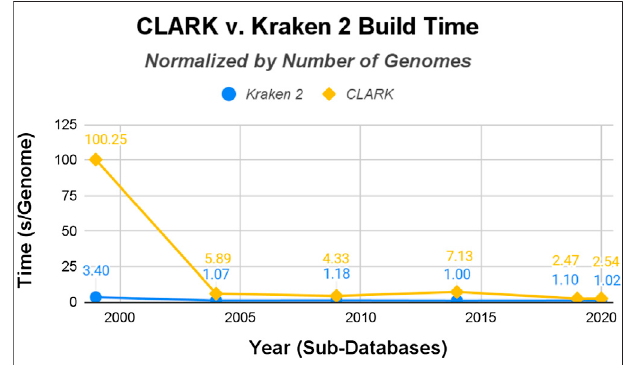
FIGURE 5 | CLARK and Kraken 2 Build Time normalized by the number of genomes in the databases (seconds/genome).